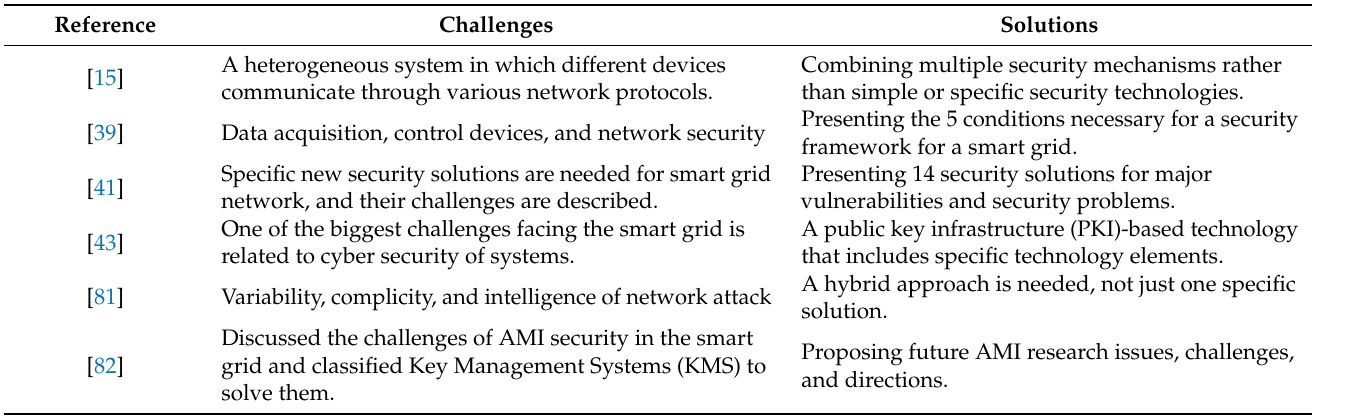
Table 4. Summary of the research papers in challenges and solutions for smart grid security